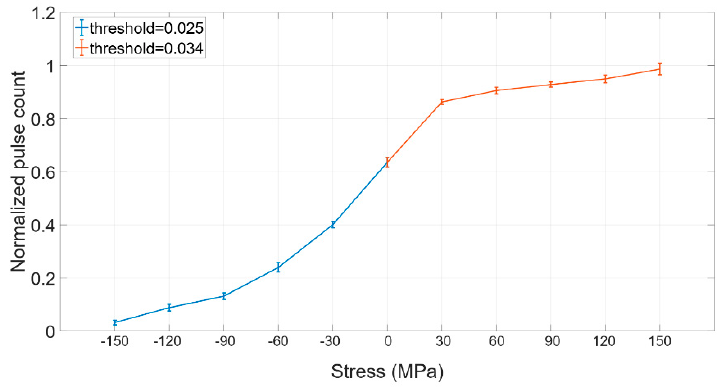
Figure 12. Diagram of multi-threshold pulse count feature as a function of stress (threshold = 0.034 for tensile stress, threshold = 0.025 for compressive stress).